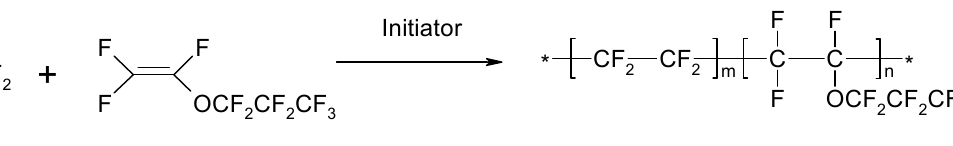
Figure 8. The preparation of